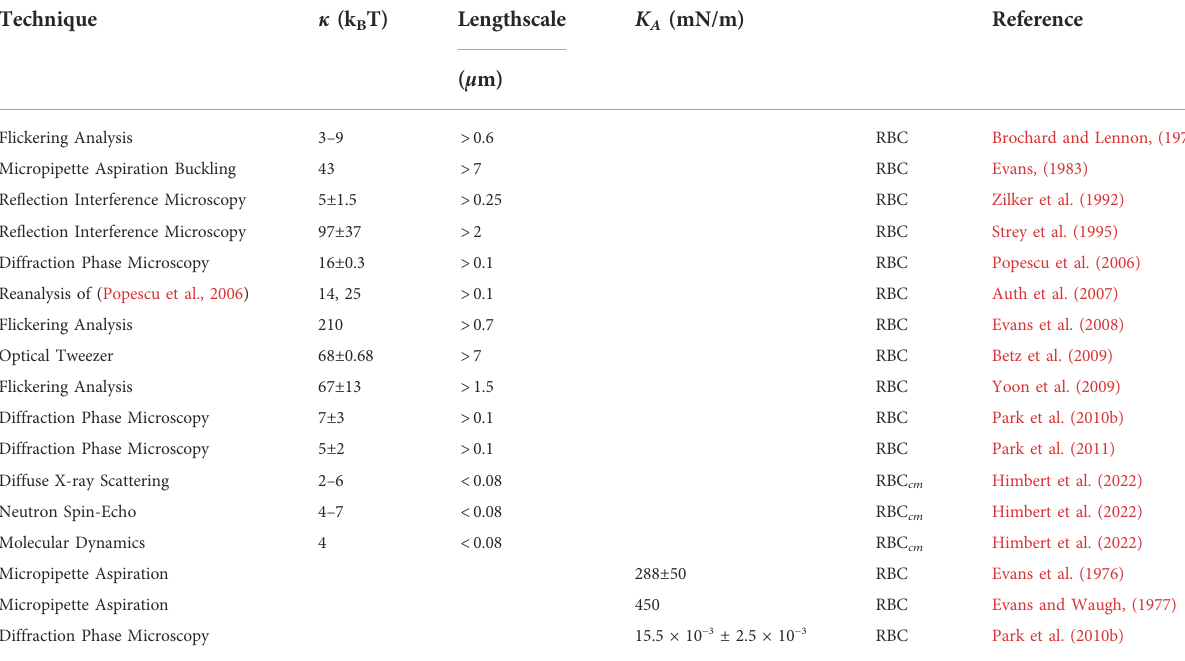
TABLE 1 Summary of values reported for the bending rigidity, κ , and the area compression modulus, K A , of discocytic RBCs and RBC cm . Also included is an estimate of the length scale on which the different techniques work.